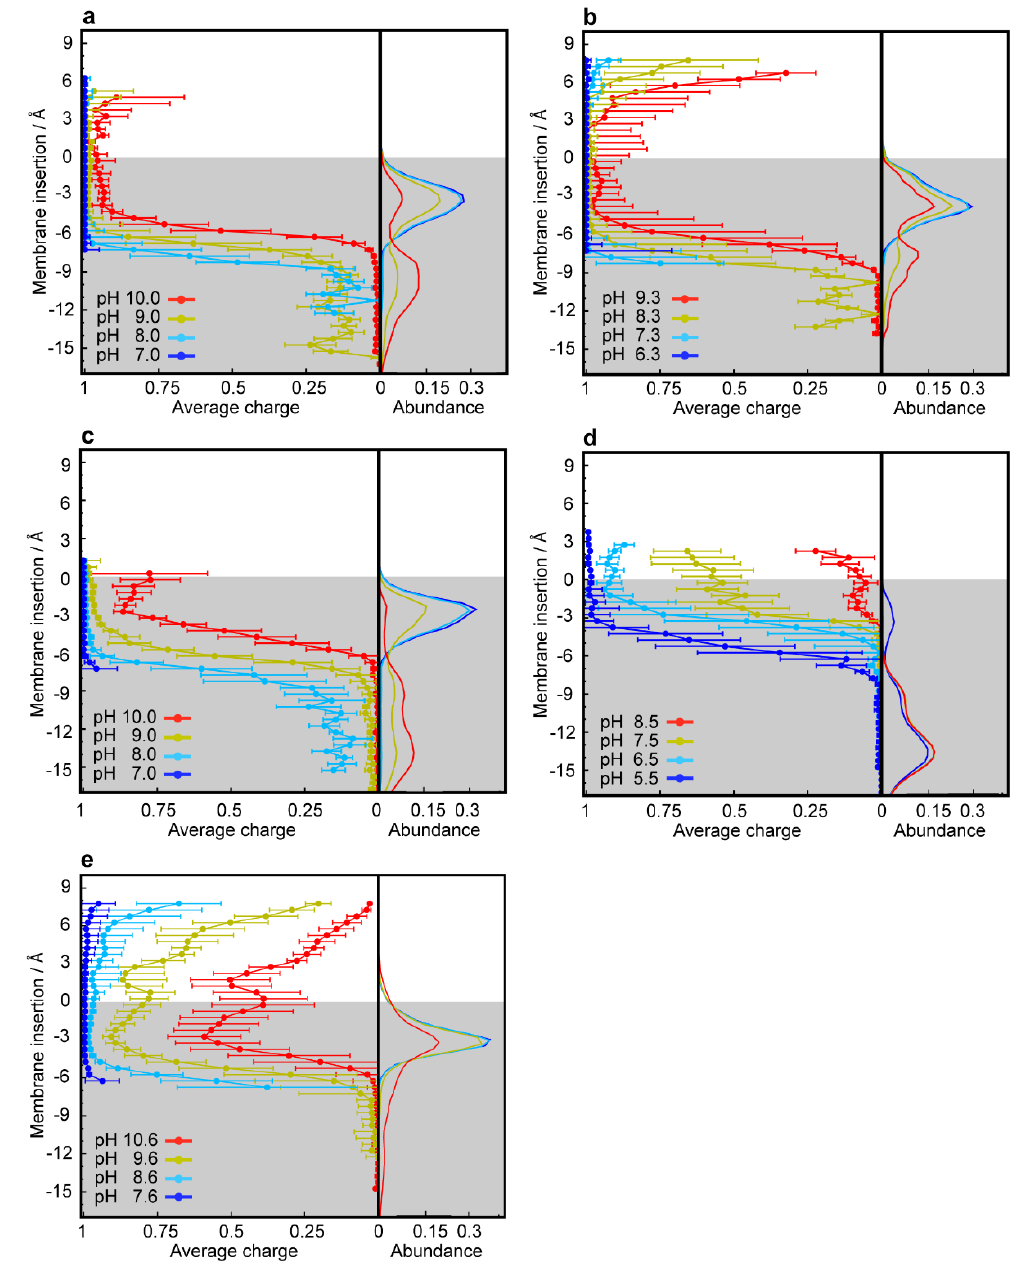
Figure 5. CpHMD simulations of the membrane insertion of lysosomotropic compounds. Average protonation (left subplots) and abundance histograms (right subplots) are depicted along the membrane insertion axis for Ethop ( a ), Pimo ( b ), Clomp ( c ), NTD ( d ) and DNR ( e ). The gray-shaded areas represent the membrane internal regions below the phosphate groups, which are used as insertion references (see Materials and Methods).